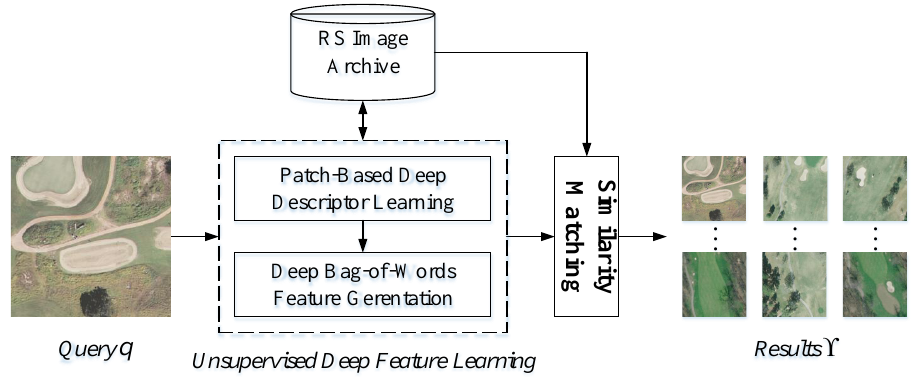
Figure 4. Framework of RSIR based on the proposed feature learning